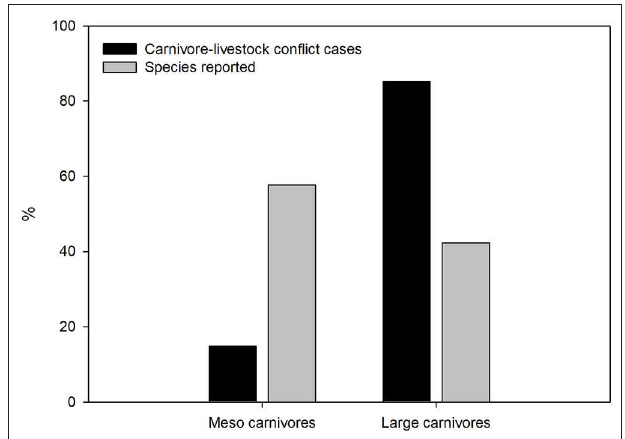
FIGURE 2 | Percentage of large and meso carnivore species reported in the carnivore-livestock conflict literature (gray bar; N = 393), and reported frequency in canivore-livestock conflict cases (black bar; N =